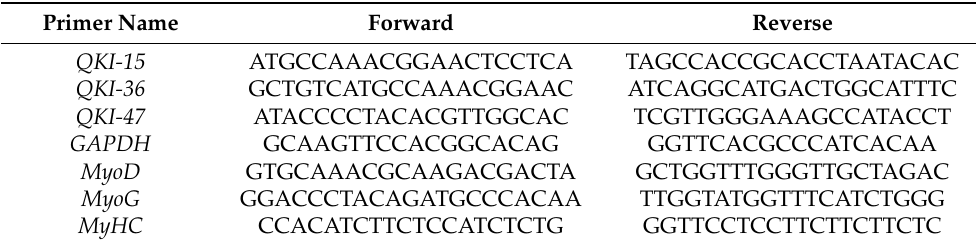
Table 1. The qPCR primer